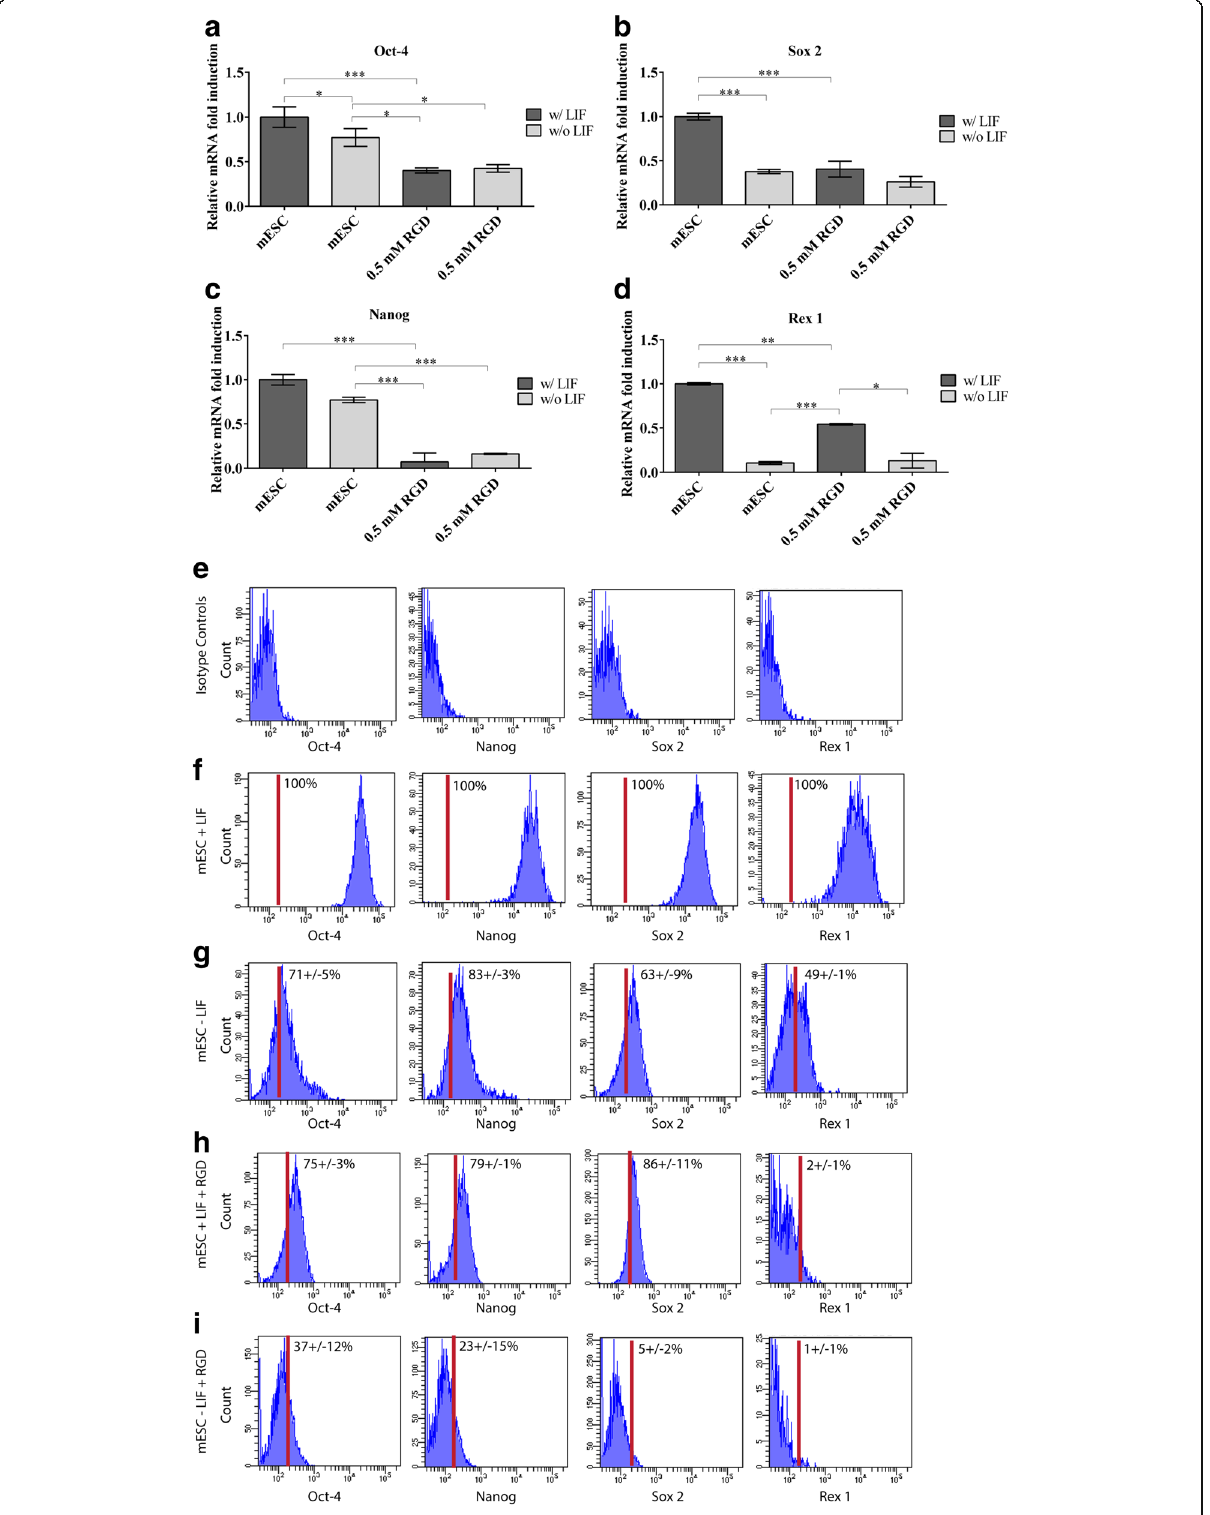
Fig. 4 Relative mRNA gene expression of pluripotent markers in the presence of cRGDfC, w/ and w/o LIF ( a - d ). Supplementation of 0.5 mM cRGDfC peptide down-regulated mESC pluripotency in the presence of LIF. Mean ± SD, n = 3 independent experimental replicates. (***;p < 0.0001; **;p < 0.001; *;p < 0.05). Flow cytometry validation of PCR data ( e - i ). Representative data from 3 independent experimental